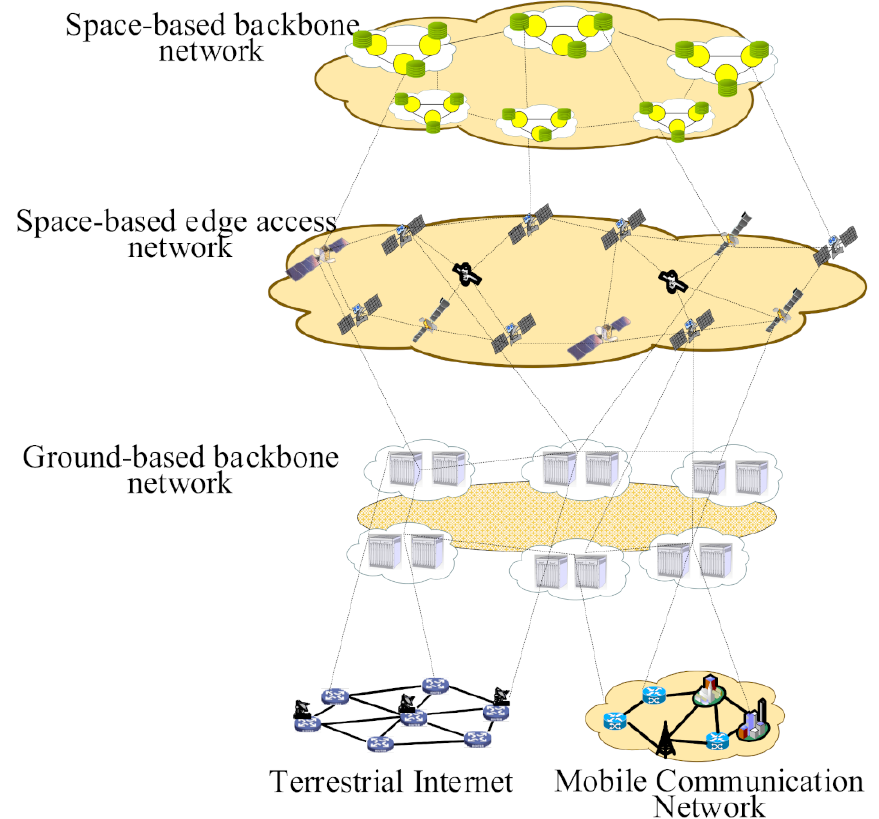
Figure 1. Architecture of the Space–Earth Integration Network. The structure of the Space–Air– Ground Integrated Network is given from the perspective of network nodes, and the space-based backbone network is the core infrastructure of the space–ground integrated information network to meet the needs of various types of communications through the integration of space and ground